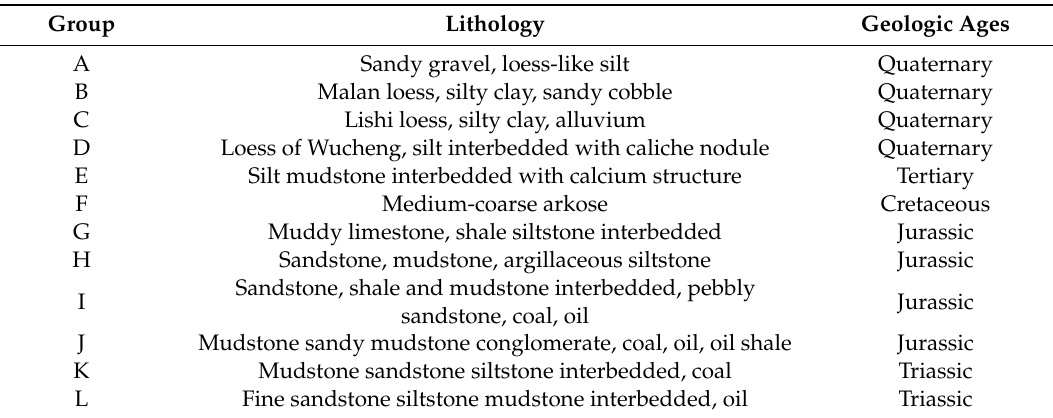
Figure 1. Geographical position of the study area. Table 1. Geological